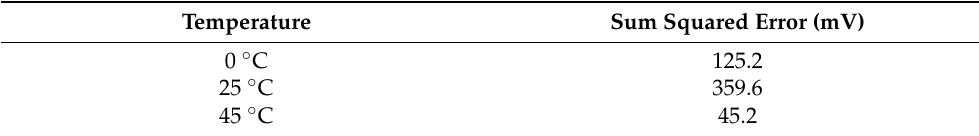
Table 8. Li-ion battery parameter estimation results. Sum squared error for measurements conducted in three different